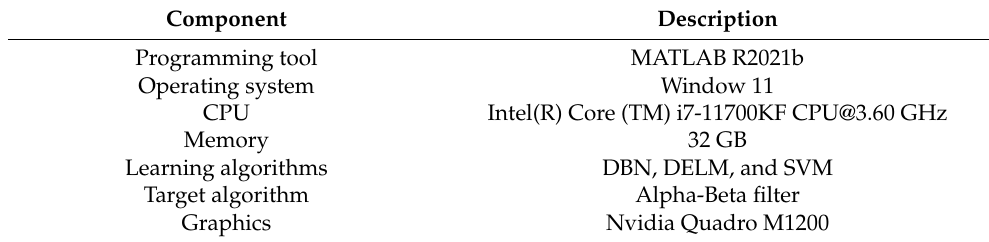
Table 2. Implementation and simulation configuration.